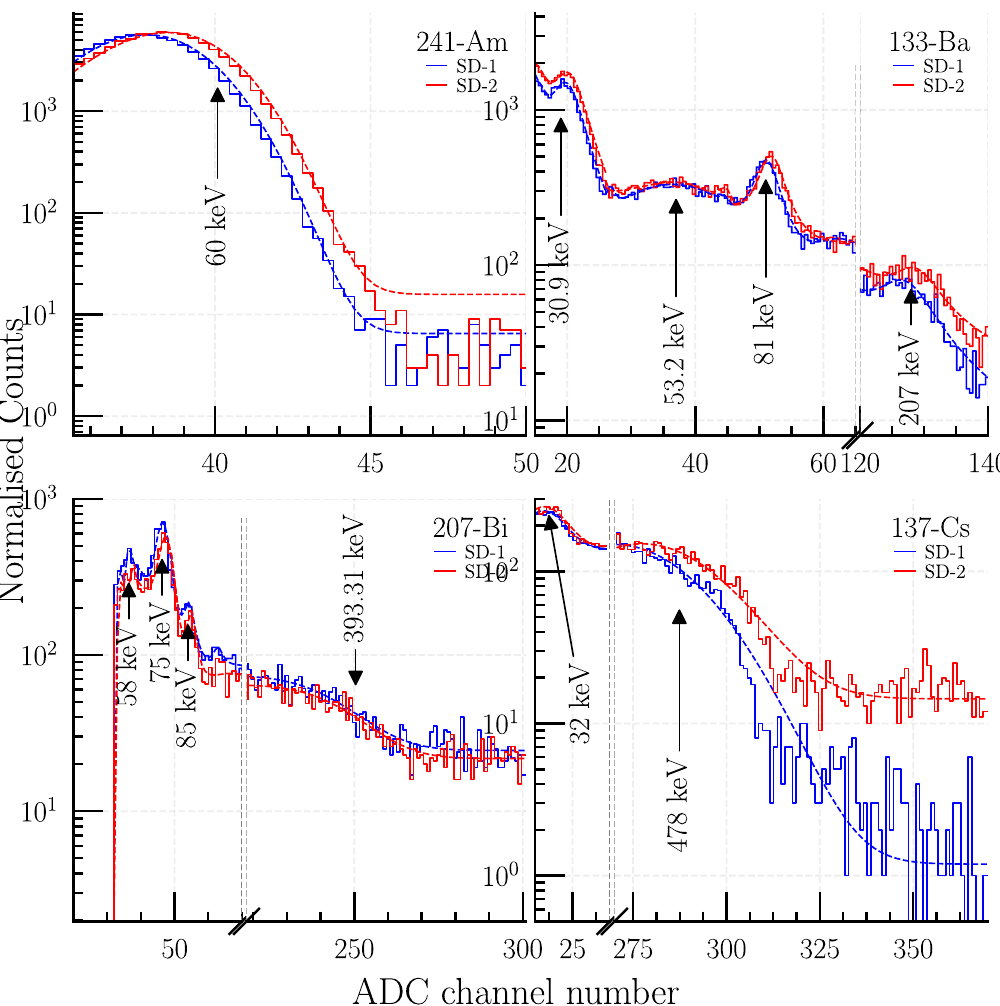
Figure A.3. The pulse height spectra of the calibration sources as measured by the two SDs of the prototype dosimeter. Supplementary data are available on the website.